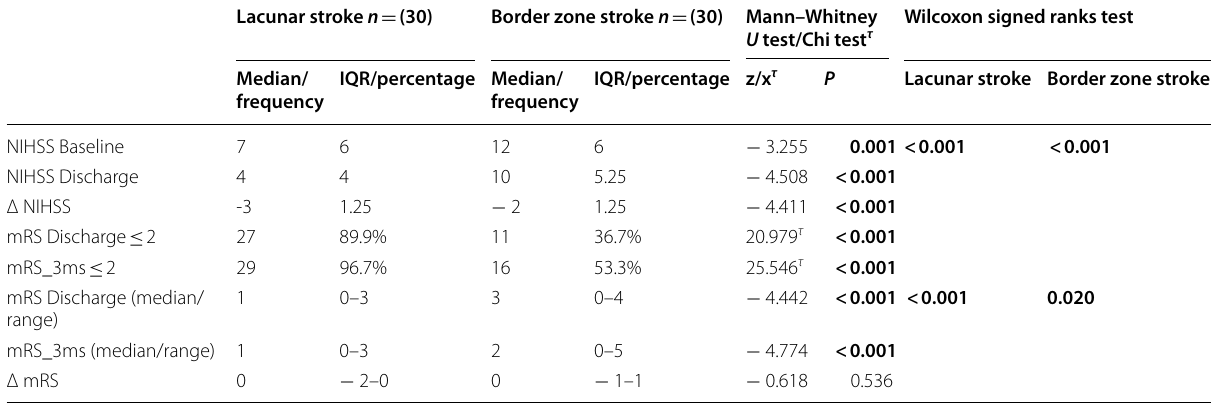
Table 2 Comparison of NIHSS and mRS between lacunar infarctions and borderzone